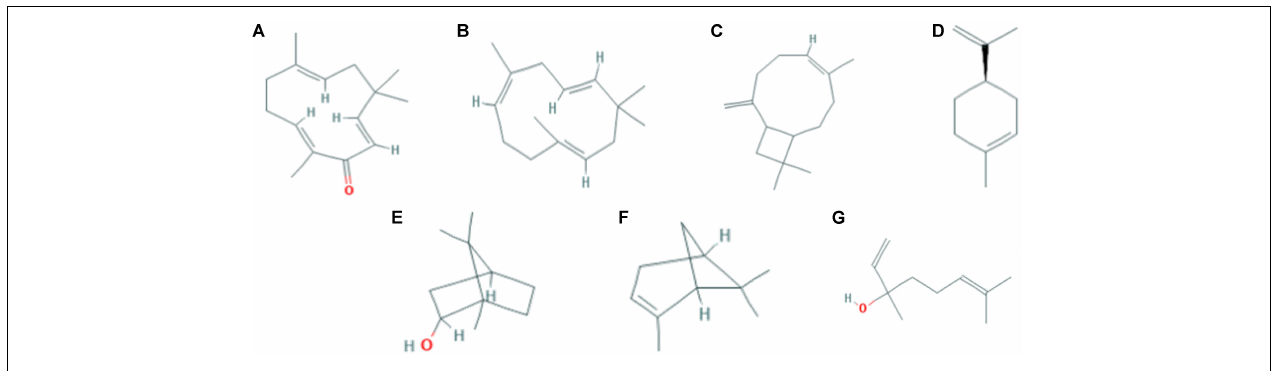
FIGURE 1 | The chemical structure of some of the major bioactive compounds that can be found in Zingiber zerumbet . (A) Zerumbone (B) α -Humulene (C) trans-Caryophyllene (D) Limonene (E) Borneol (F) α -Pinene (G)